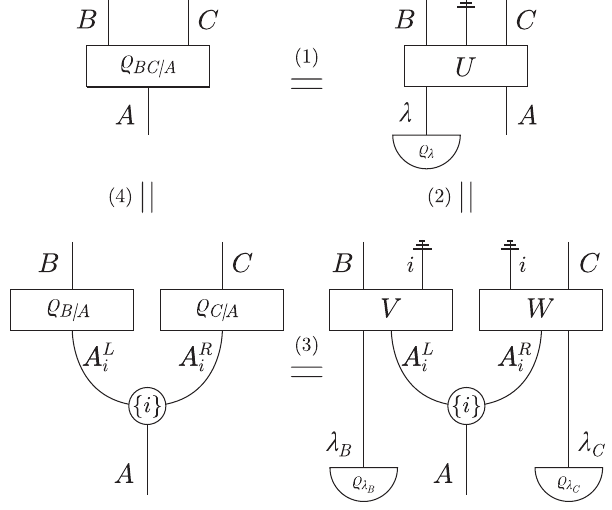
FIG. 6. Diagrammatic representation of Theorem 2 and of alternative expressions for quantum conditional independence of outputs given input (Theorem 3). Following Ref. [28], we use to denote partial trace (here, slightly generalized to include the partial trace of a wire carrying an i index, defined in an obvious